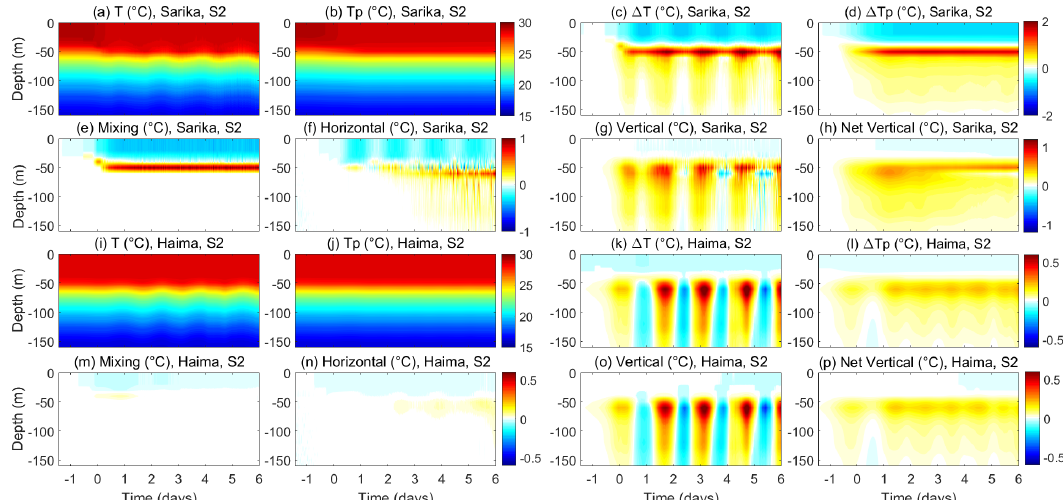
Figure 12. Change of temperature (T), net temperature (Tp), temperature anomaly ( ∆ T), net temperature anomaly ( ∆ Tp), and temperature change caused by mixing, horizontal advection, vertical advection and net vertical advection simulated by 3DPWP model during Sarika ( a – h ) and Haima ( i – p